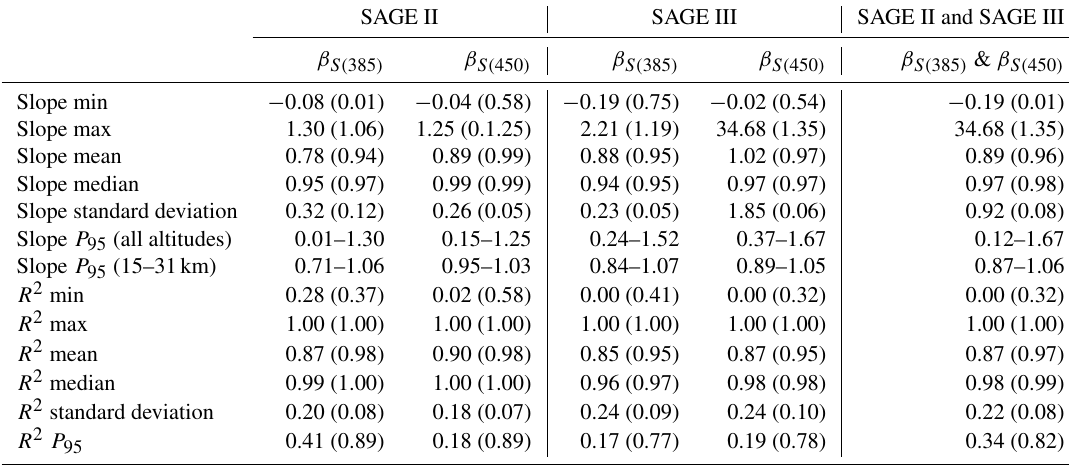
Table 1. Aggregate statistics for line-of-best-fit slope and R 2 for the SAGE II and SAGE III products compared to β S( 520 ) . Values in parentheses were calculated after restricting the dataset to altitudes between 15 and 31km. The last column was calculated using data from both missions and backscatter values calculated using both β S( 385 ) and β S( 385 ) . The slope P 95 data show the range of slopes (centered on the